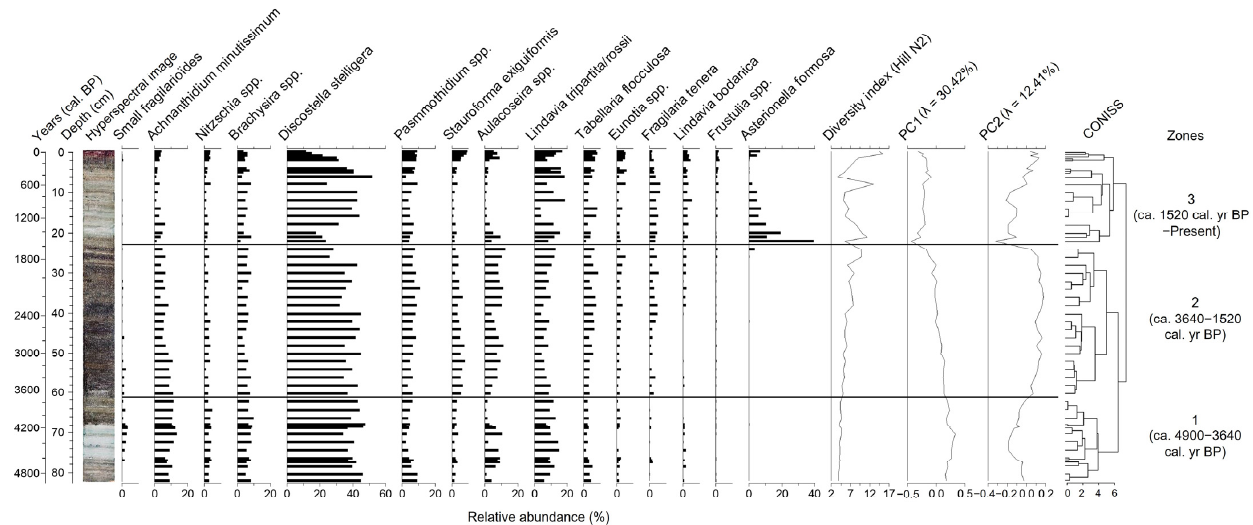
Figure 4. Relative abundance (%) of the most common diatoms ( ≥ 4% in at least one level), diversity index, sample coordinates along the two main PCA axes, and biostratigraphic zones (CONISS) of the Oakes Bay West Lake core. Oakes Bay West Lake Zone 1 (82.5–62 cm) was dominated by the small centric planktonic species Discostella stelligera , representing between 34.2 and 47.9% of the assemblage, as well as Lindavia